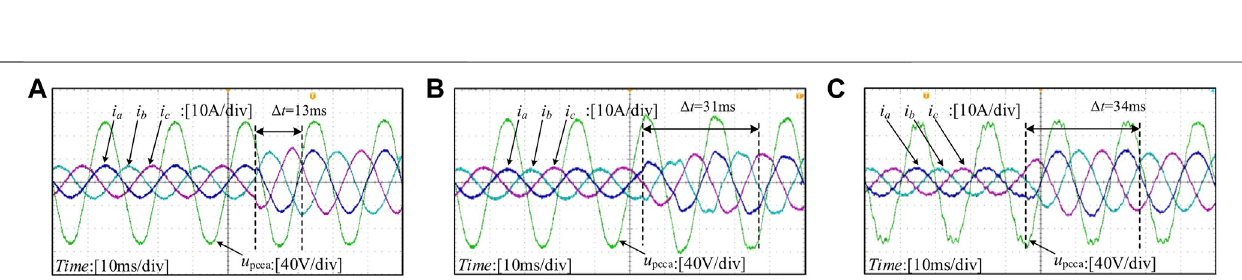
Frontiers in Energy Research |